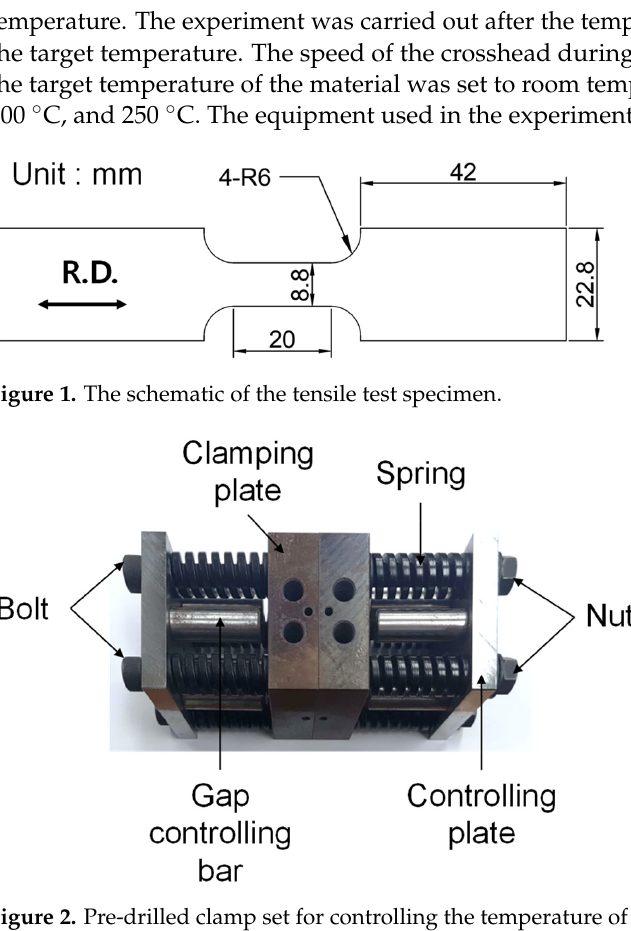
Figure 1. The schematic of the tensile test specimen.